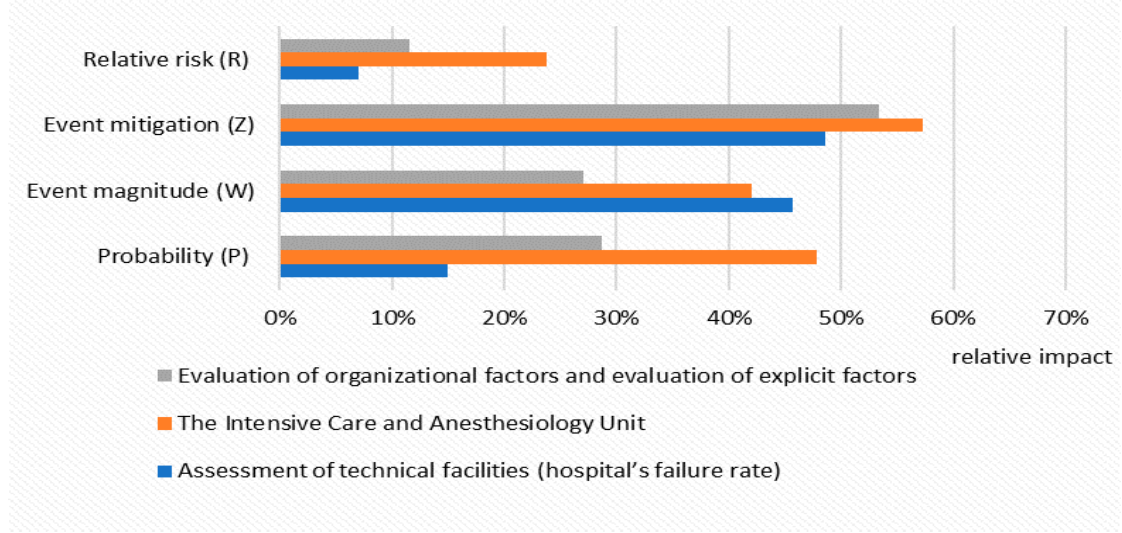
Figure 3. Relative risk (R) of C. difficile infections for hospitalized patient in selected risk categories, with specific parameters included in the PM model.